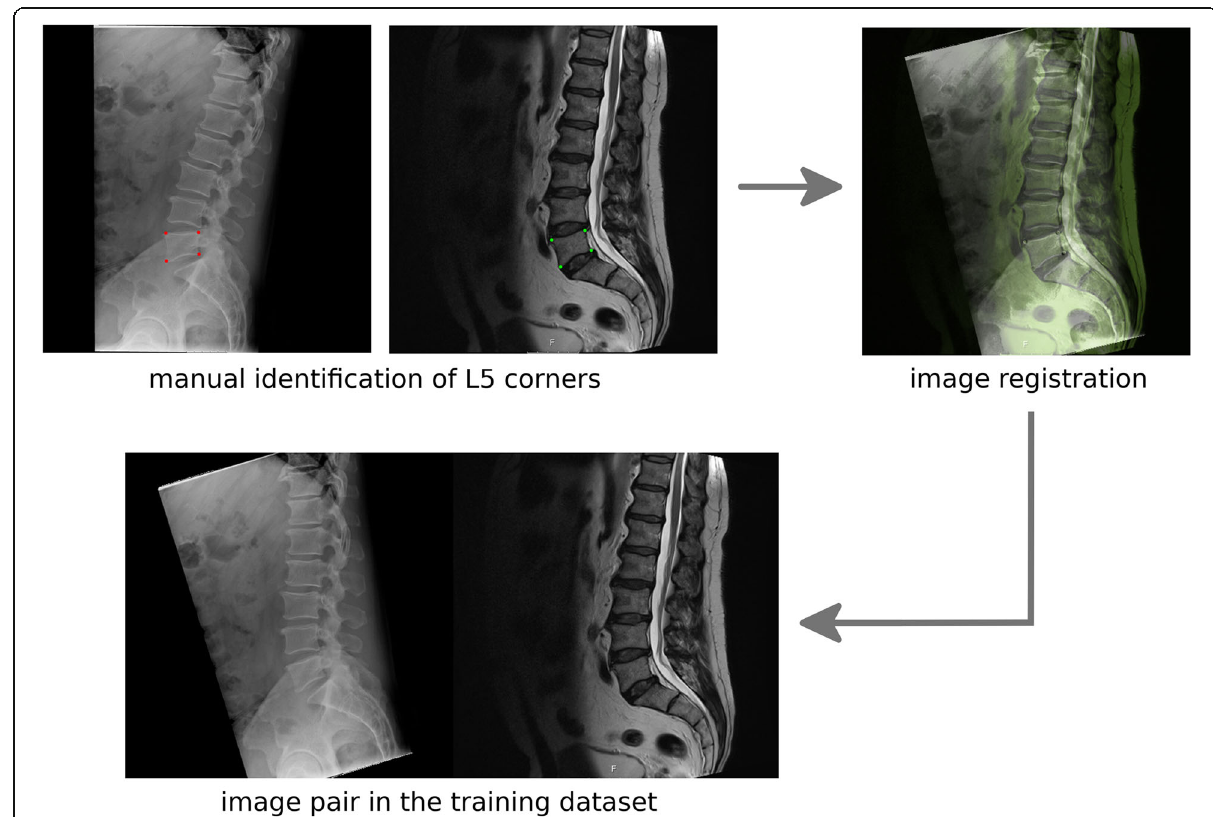
Fig. 1 The manual registration procedure used for the alignment of the sagittal x-ray projections and the midsagittal T2W MRI scans. First, the vertebral corners of L5 are manually identified on both images. Then, a rigid registration is performed and the pair of registered images is added to the training